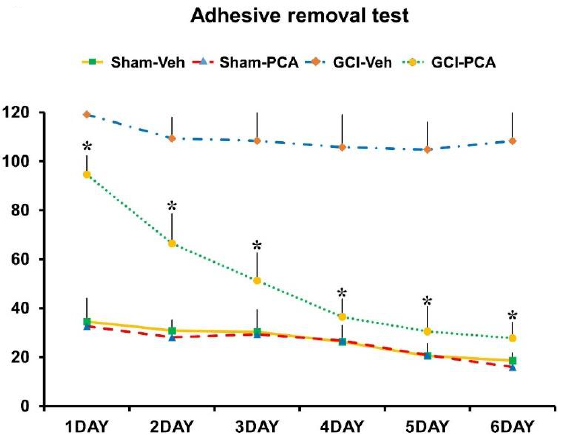
Figure 8. PCA administration improves cognitive function after ischemia. Rats administered PCA for 7 days after ischemia were evaluated for changes in cognitive and sensory function by the adhesive removal test. The graphs show the measured cognitive ability from each group. As a result, injection of PCA lead to increased improvement of ischemia-induced cognitive impairment, compared to the vehicle-treated group. Data reflect the mean ± S.E.M., n = 5 from each sham group and n = 8 form each ischemia group. * Significantly different from the vehicle-treated group, p < 0.05.